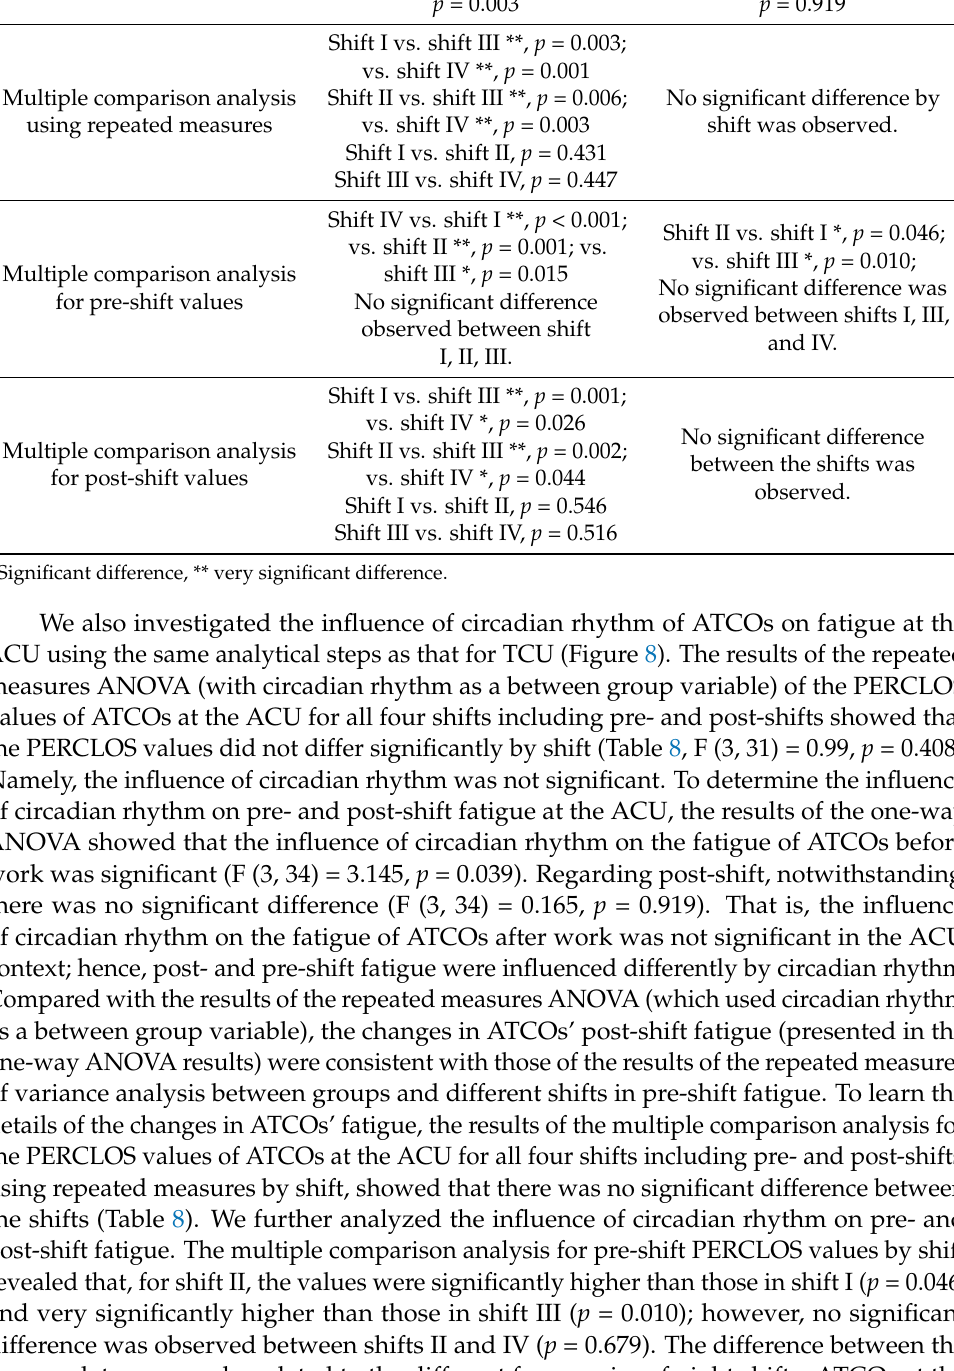
Table 8. Comparisons of the influence of circadian rhythm on ATCOs’ PERCLOS values by work type. Statistical Method TCU ACU Among the shifts **, Among the shifts, Repeated measures ANOVA F (3, 28) = 7.07, p = 0.001 F (3, 31) = 0.99, p = 0.408 Pre-shift *, F (3, 34) = 3.145, Pre-shift **, p = 0.039 F (3, 31) = 7.071, p = 0.001 One-way ANOVA Post-shift, F (3, 34) = 0.165, Post-shift **, F (3, 31) = 6.049, p = 0.919 p = 0.003 Shift I vs. shift III **, p = 0.003; Multiple comparison analysis using repeated measures